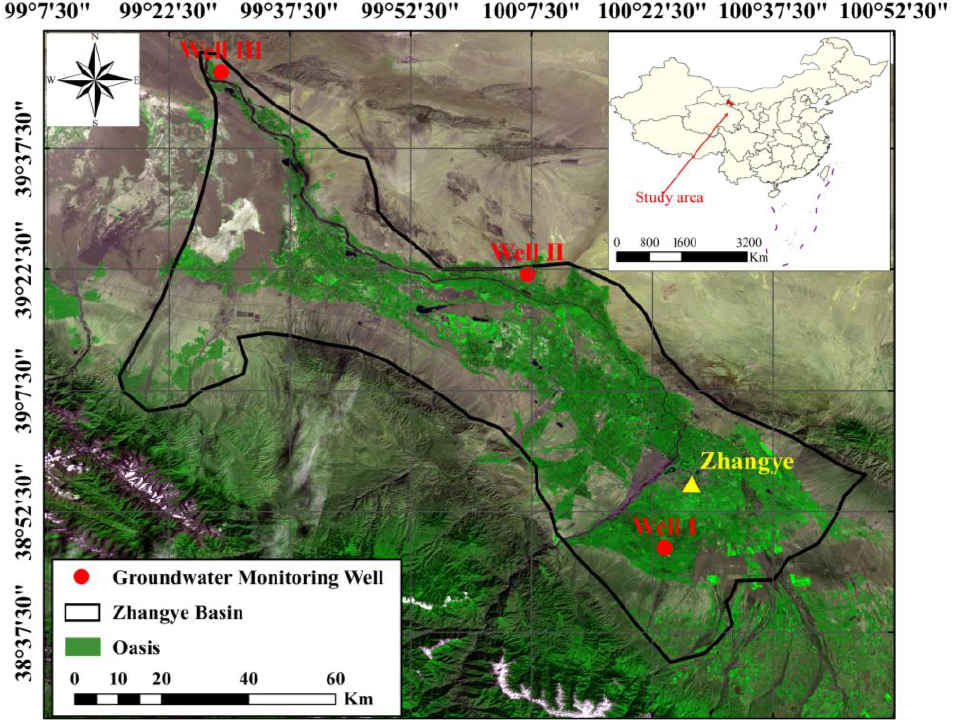
Figure 1. The Zhangye Basin and the groundwater level monitoring wells.